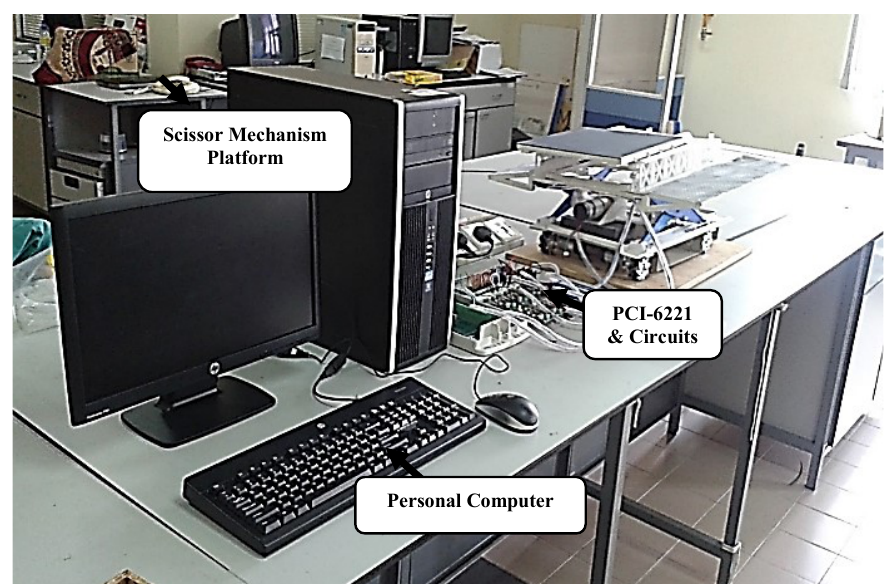
Figure 3. Experimental setup of scissor mechanism platform